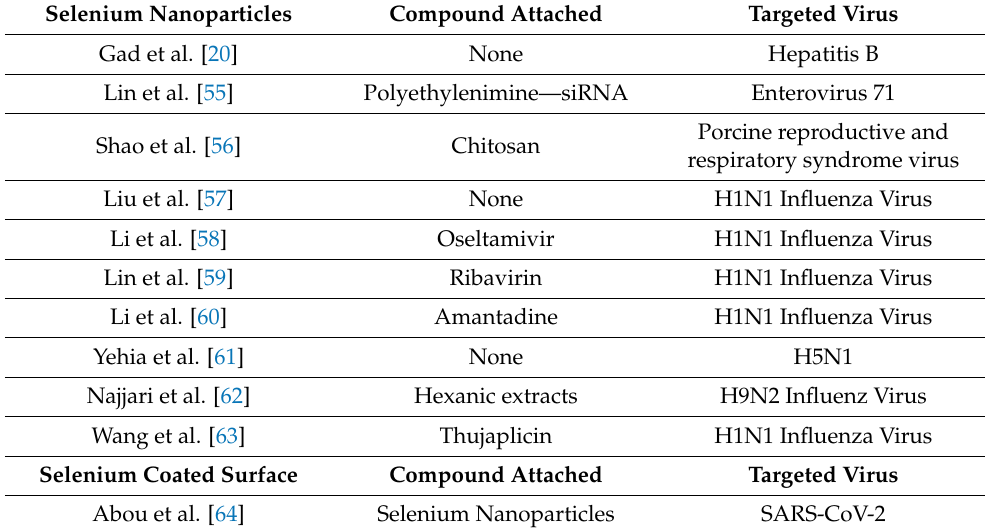
Table 1. Selenium Nano-particles and Coated Surfaces against Viral